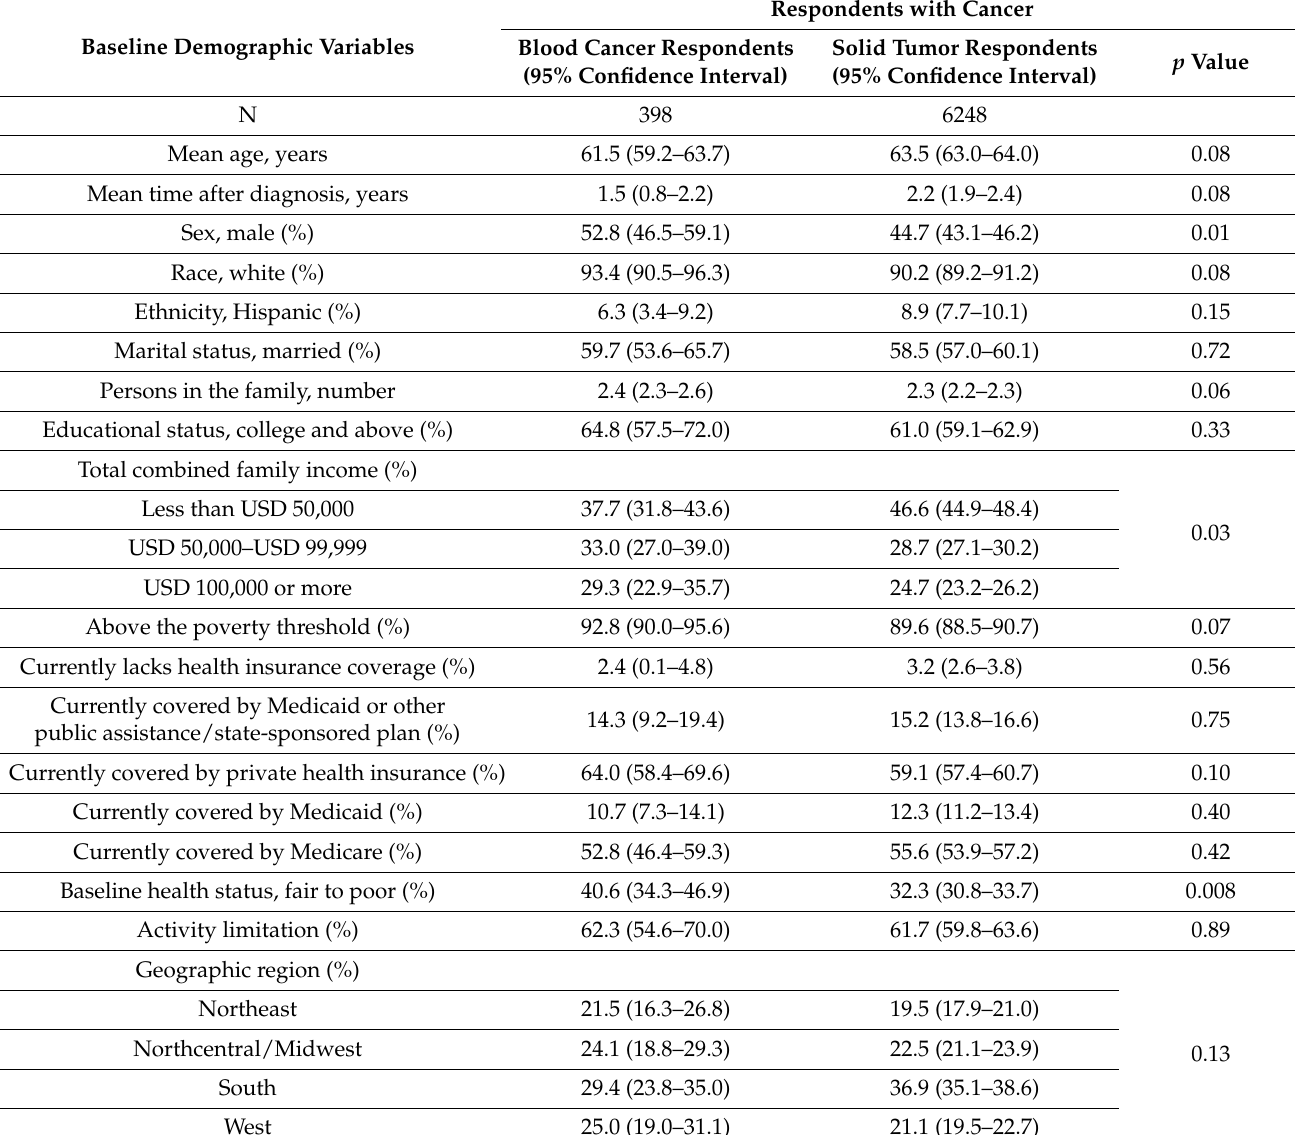
Table 1. Respondent